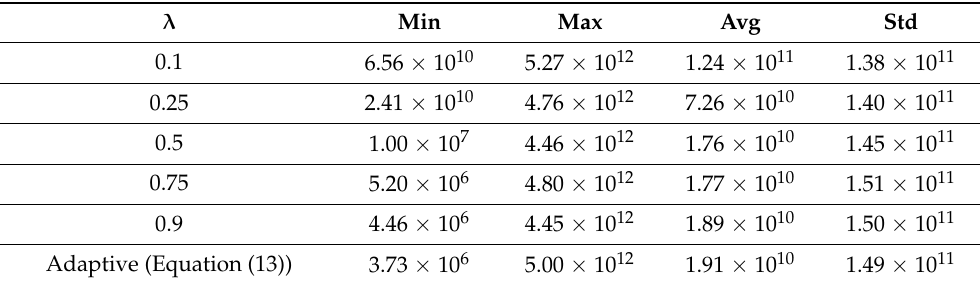
Table 3. The analysis of adaptive